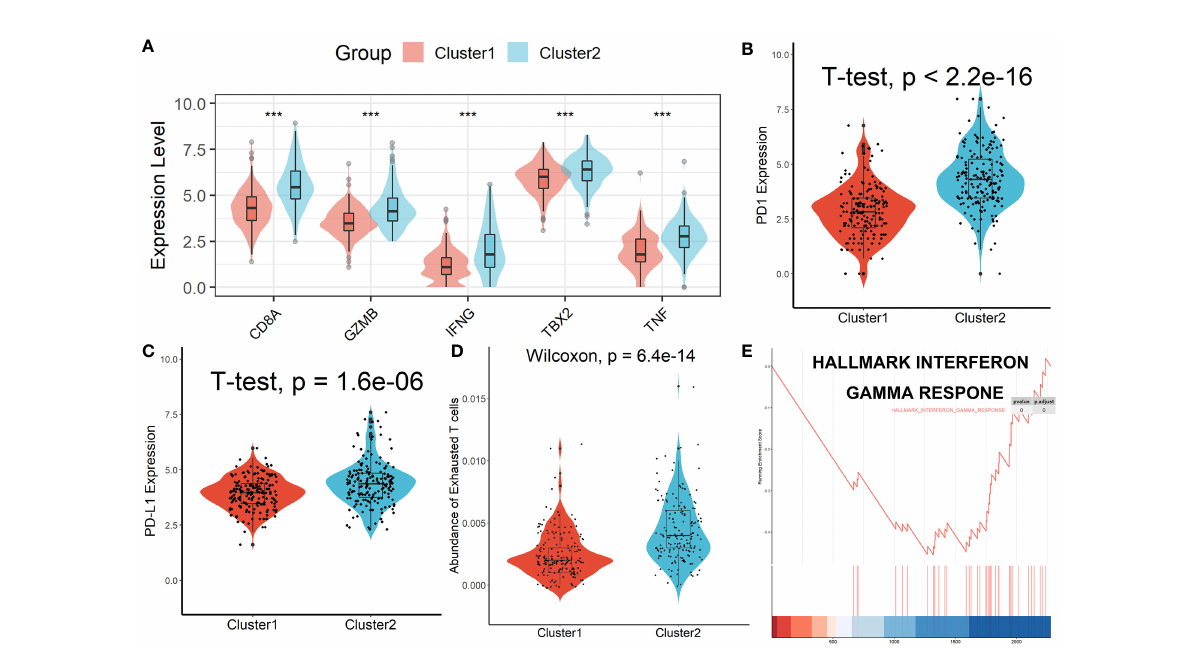
FIGURE 4 Patients in Cluster 2 had an Exhausted Immune Microenvironment. (A) Differential analysis of in fl ammation/immune response-related genes. (B, C) Differential analysis of PD1 and PD-L1 expression. (D) Exhausted T cells were signi fi cantly enriched in Cluster 2. (E) Cluster 1 displayed an attenuated IFN- g response. ***p <